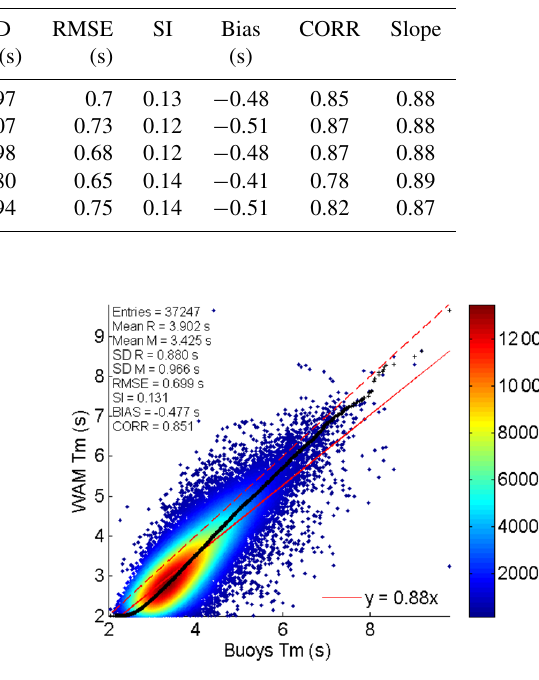
Figure 9. QQ–scatter plots of Med-waves output versus wave buoy observations, for the full Mediterranean Sea, for a 1-year pe- riod